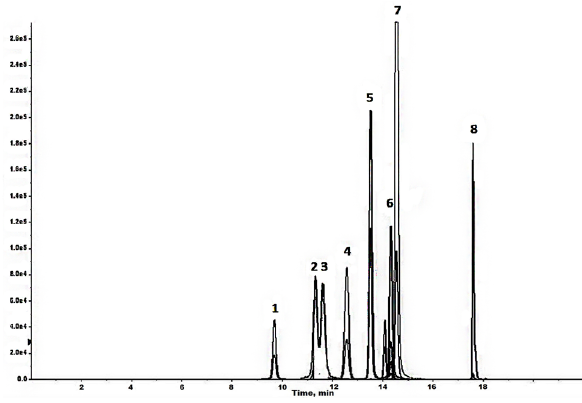
Figure 2: Exemplary LC-ESI-MS/MS chromatogram of analyzed flavonoid glycosides. For compound numbers see Table 2. See Experimental section for